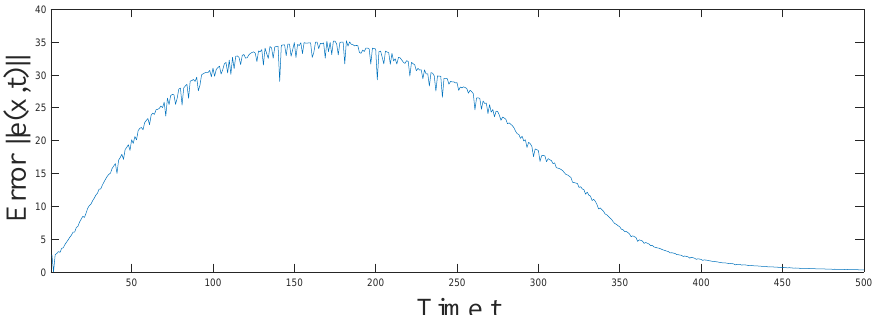
Figure 3. Time evolution of the synchronization error (cid:107) e ( x , t ) (cid:107) between systems (2) and (3) without controller at x = 0.698.